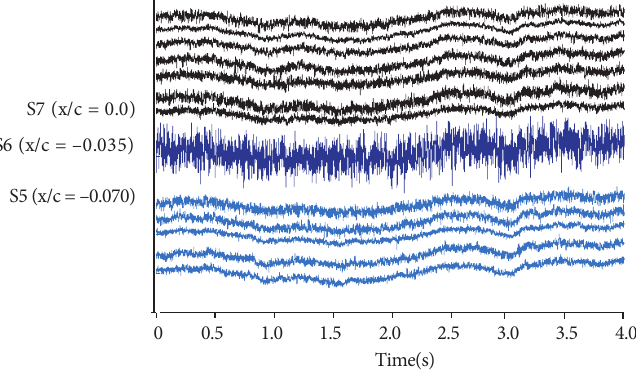
Figure 14. Time history of hot wires output signals at AOA =